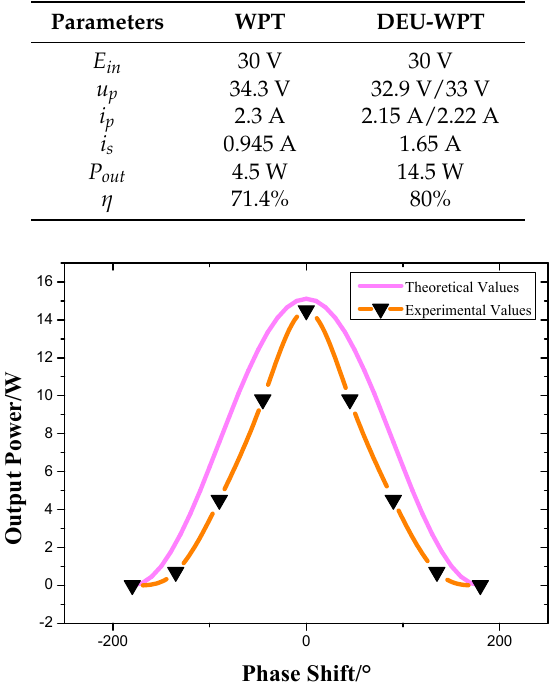
Table 4. Comparison of experimental results.